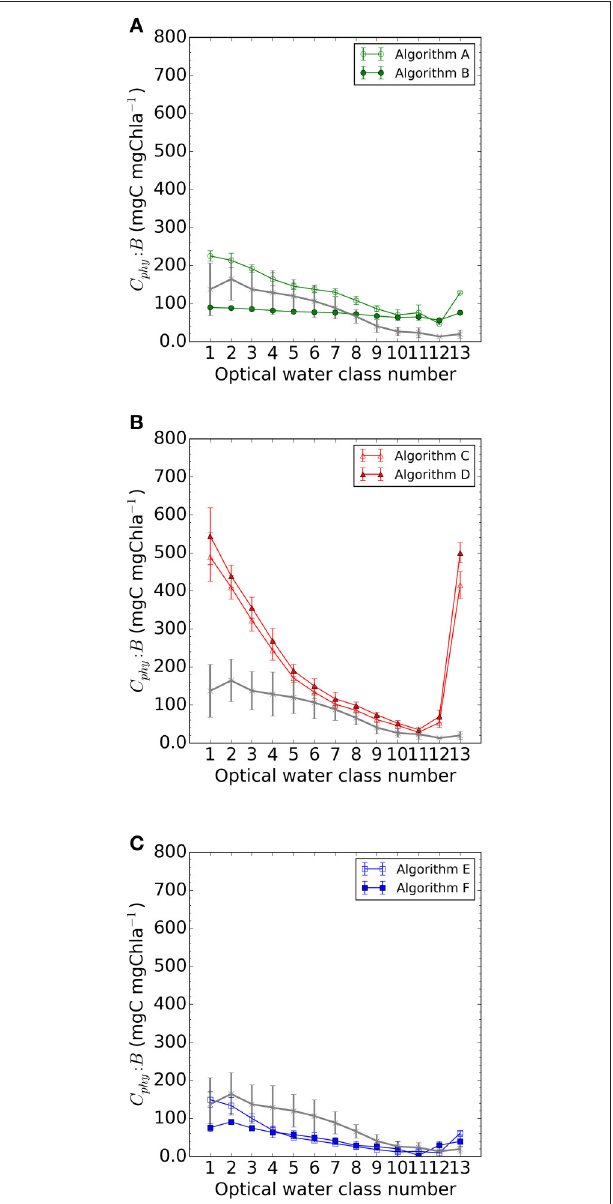
FIGURE 8 | Median C phy : B for each optical water class in the match-up dataset per type of algorithm: (A) chlorophyll-based algorithms A and B; (B) backscattering-based algorithms C and D and (C) allometric algorithms E and F. Error bars are the IQR/2 for the water class. Gray line and error bars in all sub-figures are obtained from the in situ dataset.